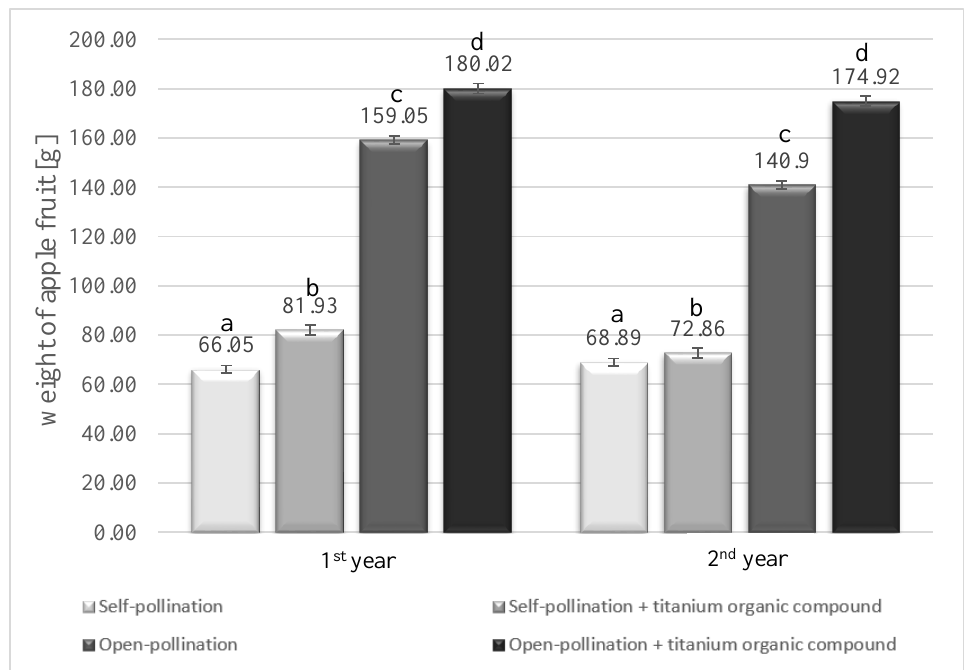
Figure 4. The effect of titanium organic complex application on the weight of apple fruit (g). Statistical analysis was performed separately for each year, significant homogenous groups were determined by Tukey’s Honest Significant Difference test; a–d—means within each year followed by different letters differ at p < 0.05; number of fruits evaluated for each treatment n = 120.